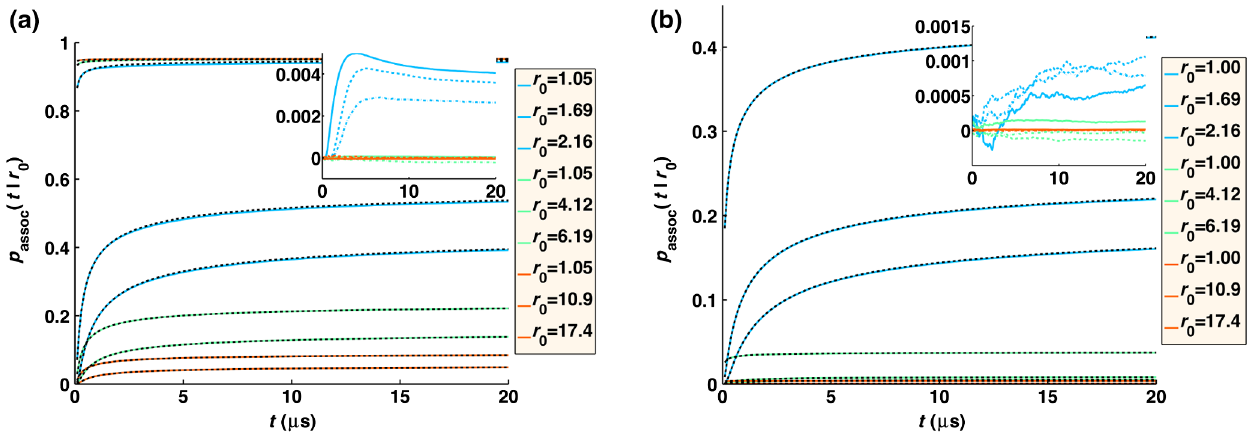
FIG. 1. Probability of two particles having associated between times 0 and t , given they were separated by a distance r 0 at t ¼ 0 . Results for the exact propagator are shown as black dashed lines [Eq. (12)], where the binding radius is σ ¼ 1 nm. The probability of associating from FPR simulations is shown for D AB ¼ 1 nm 2 = μ s (blue), D AB ¼ 20 nm 2 = μ s (green), and D AB ¼ 200 nm 2 = μ s (orange). (a) Results for perfectly absorbing boundary ( k a ¼ ∞ ) and a time step of Δ t ¼ 0 . 1 μ s. Simulations are averaged over 10 6 trajectories each initialized to the prescribed r 0 . The inset plots the difference between exact and simulated results [ p The simulated results marginally underestimate the association rate due to incomplete trajectory sampling, with errors being largest for slow diffusion. (b) Same as (a) but with radiation BCs at σ ¼ 1 nm with k a ¼ 10 nm 3 = μ s. For this lower rate (relative to absorbing where k a ¼ ∞ ), the error is smaller for all D AB